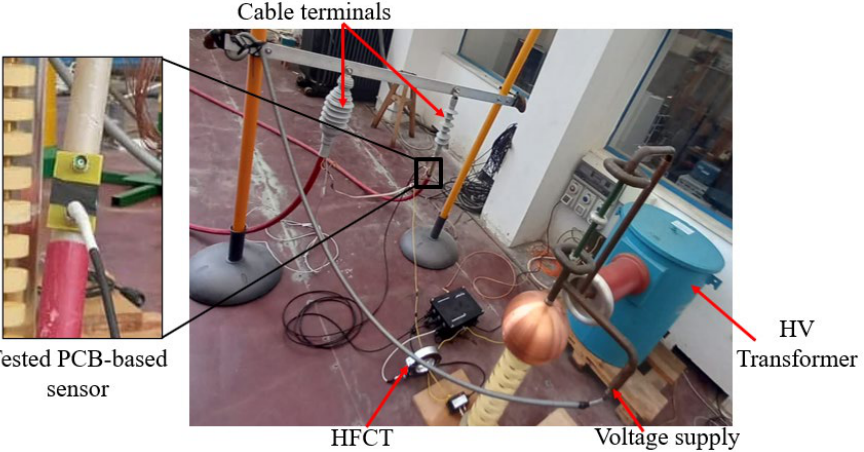
Figure 5. Measurement laboratory setup of PDs in the MV power cable (enlarged image is showing the spiral inductor in position P1).